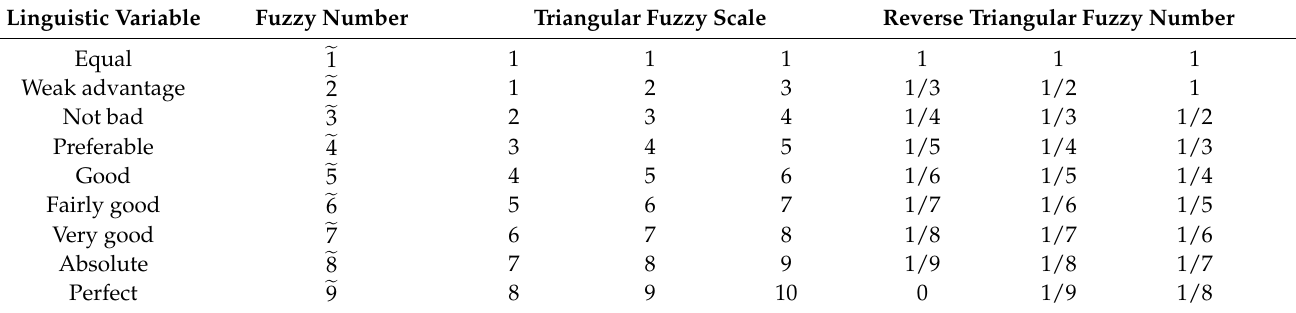
Table 2. Linguistic scales of criteria’s rating for FAHP [35].